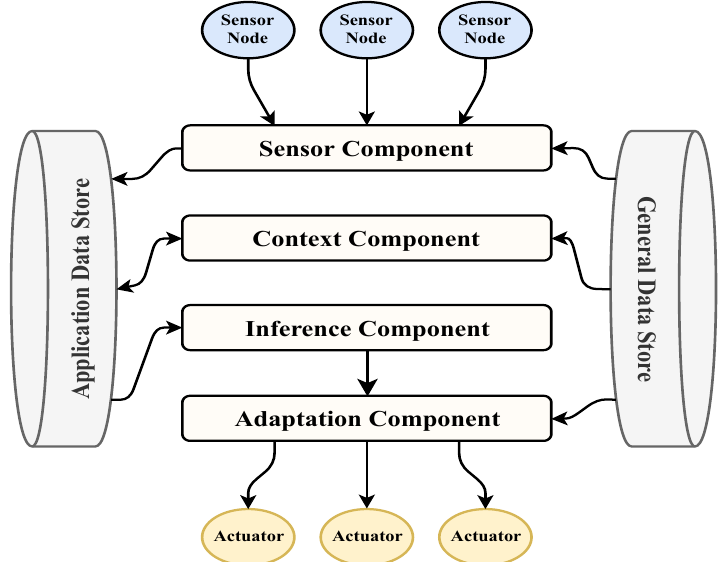
Figure 20. Context-Aware Architecture for Smart